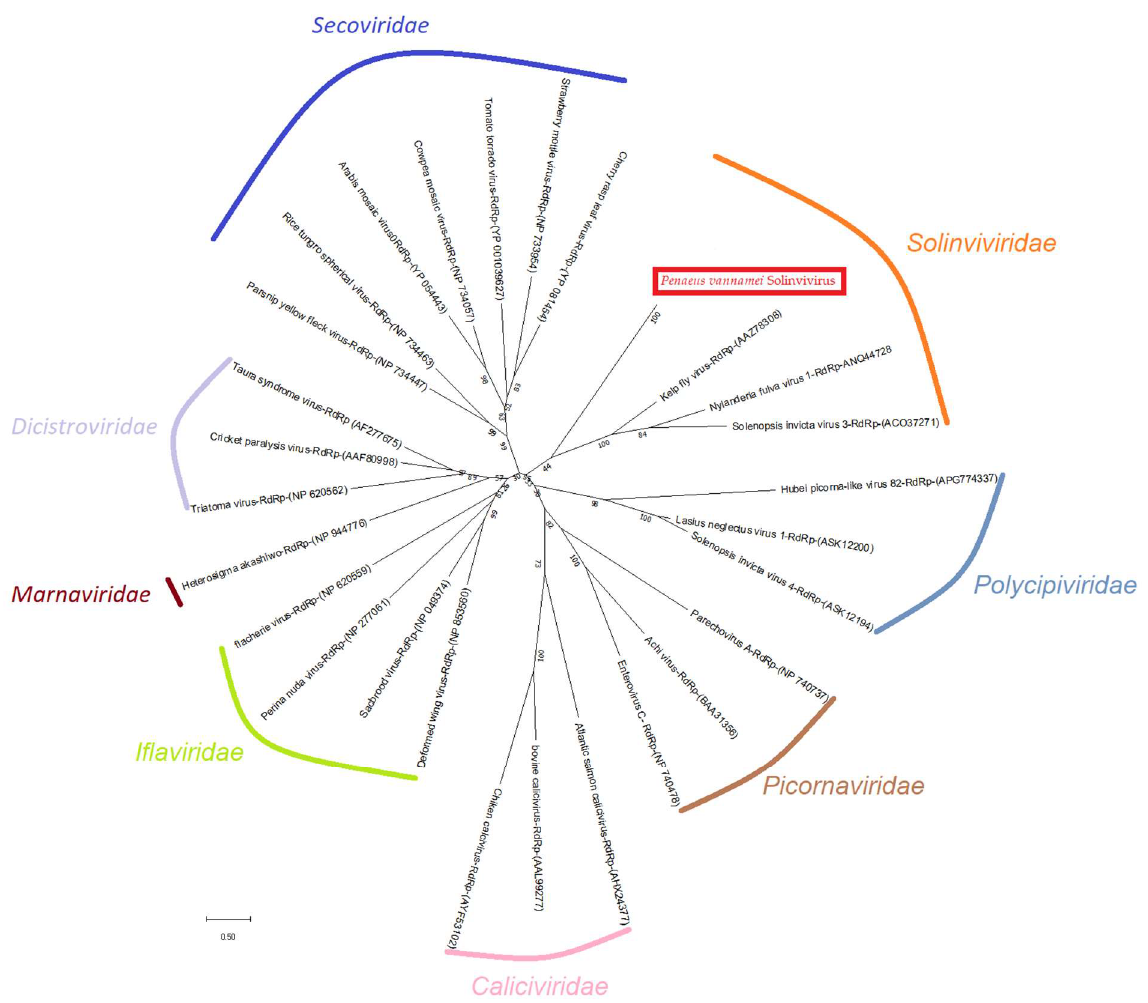
Figure 2. The evolutionary history of Penaeus vannamei solinvivirus (PvSV) was inferred using the Neighbor-Joining method. The figure shows the PvSV clusters with the family Solinviviridae and is divergent from the rest of the viruses in this family. The optimal tree with the sum of branch length = 16.70591706 is shown. The percentage of replicate trees in which the associated taxa clustered together in the bootstrap test (1000 replicates) are shown next to the branches. The tree is drawn to scale, with branch lengths in the same units as those of the evolutionary distances used to infer the phyloge- netic tree. The evolutionary distances were computed using the Poisson correction method and are in the units of the number of amino acid substitutions per site. This analysis involved 29 amino acid sequences. All ambiguous positions were removed for each sequence pair (pairwise deletion option). There was a total of 610 positions in the final